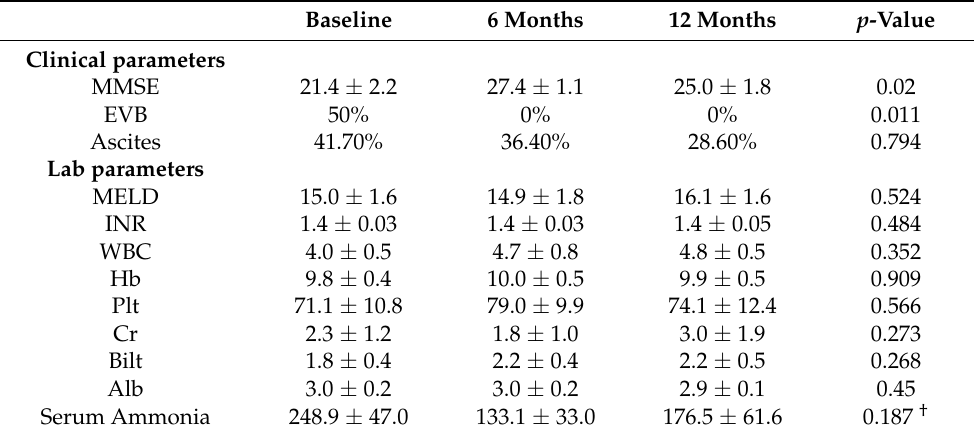
Table 4. Comparisons of clinical and laboratory parameters at baseline and after rifaximin plus lactulose initiated in patients (N = 12) during different follow-up visits.